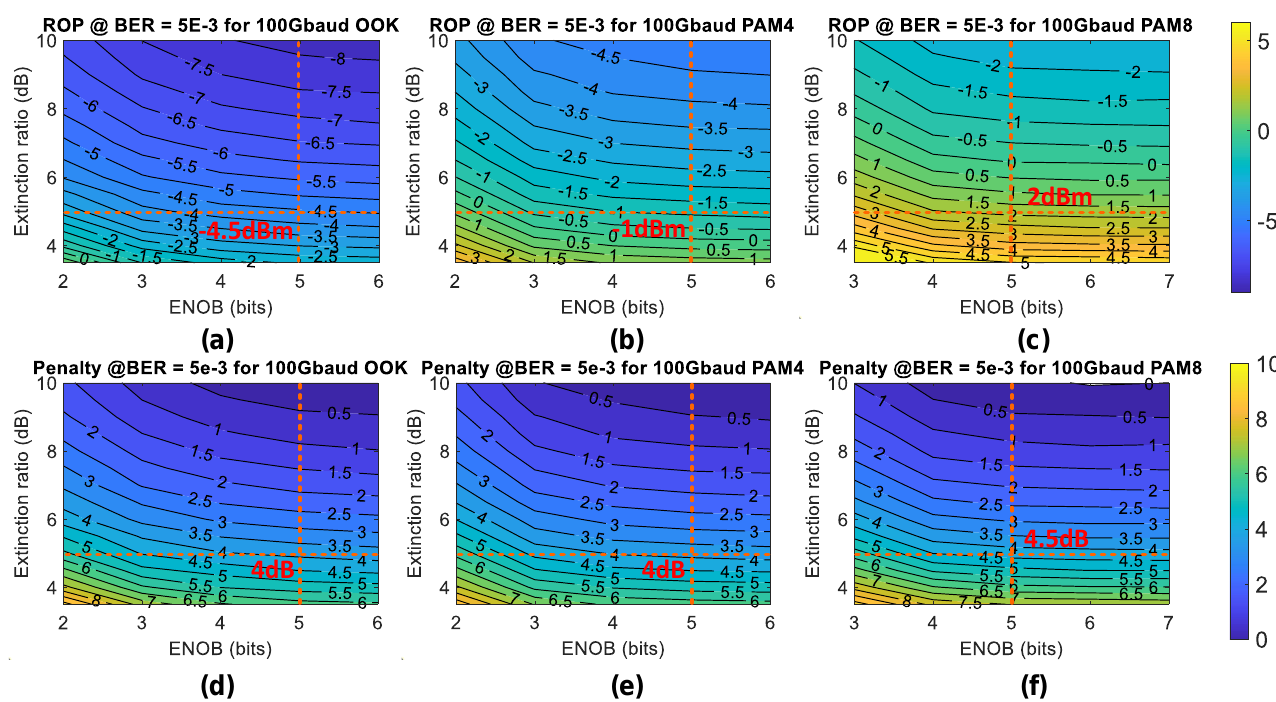
Figure 6. Extinction ratio versus the effective number of bits in terms of received optical power and penalty for 100 Gbaud ( a , d ) OOK, ( b , e ) 8PAM4, and ( c , f ) PAM8 signals for 6-FFT and 3FBT equalizer configuration at optical b2b.